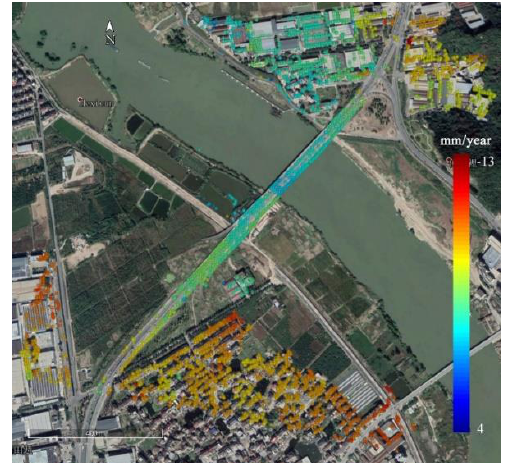
Figure 6. The deformation velocity difference diagram of the same points between the method in this paper and the initial point selection